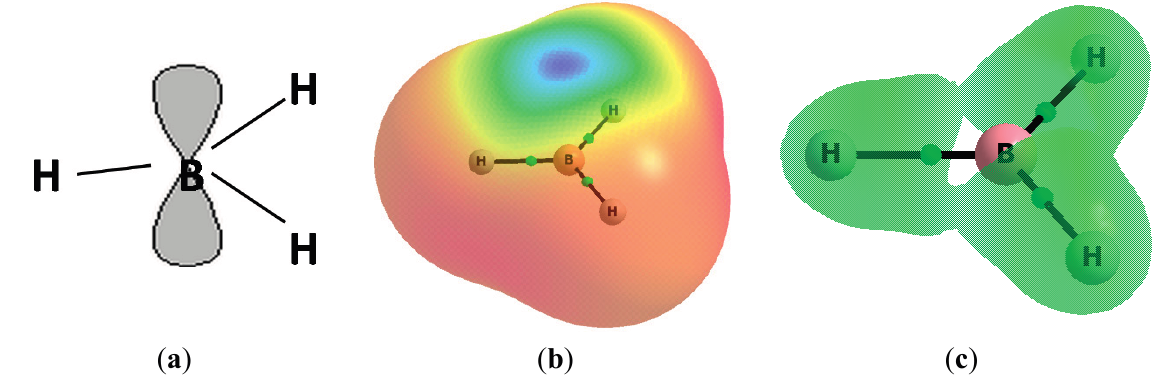
Figure 1. The BH 3 molecule, ( a ) scheme showing the vacant p-orbital; ( b ) the electrostatic potential surface calculated for the 0.001 au electron density, red and blue colors correspond to negative and positive EP, respectively; ( c ) the molecular graph of the BH 3 molecule with the reactive surface. Big circles correspond to atomic attractors and small green circles to the bond critical point; results of the MP2/aug-cc-pVTZ